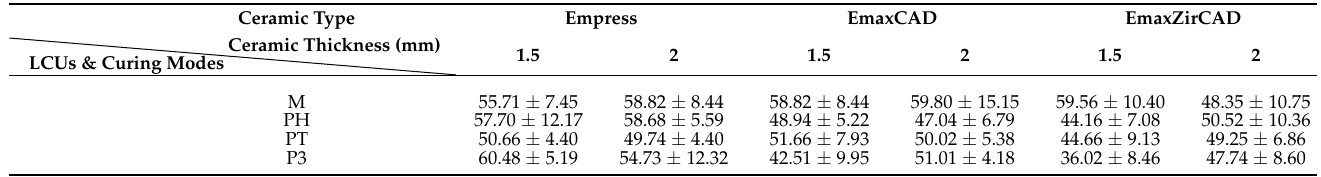
Table 3. Mean and standard deviation of degree of cure test